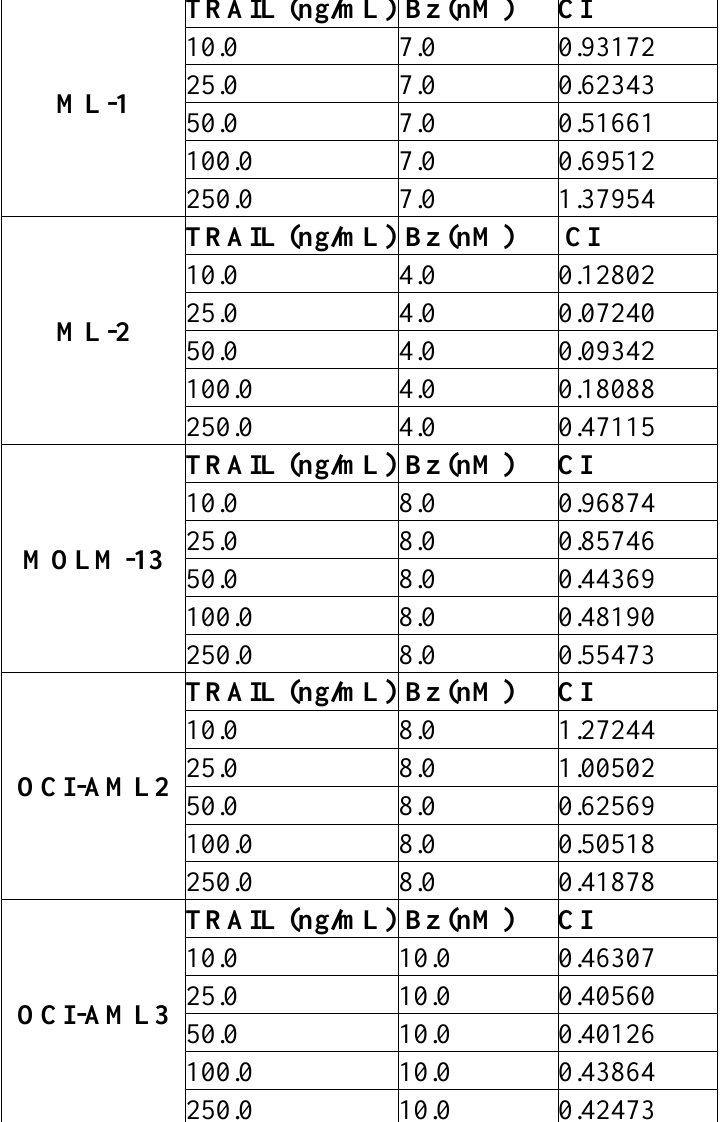
Table 1. CI values of synergistic drug interactions in M4/M5 AML cell